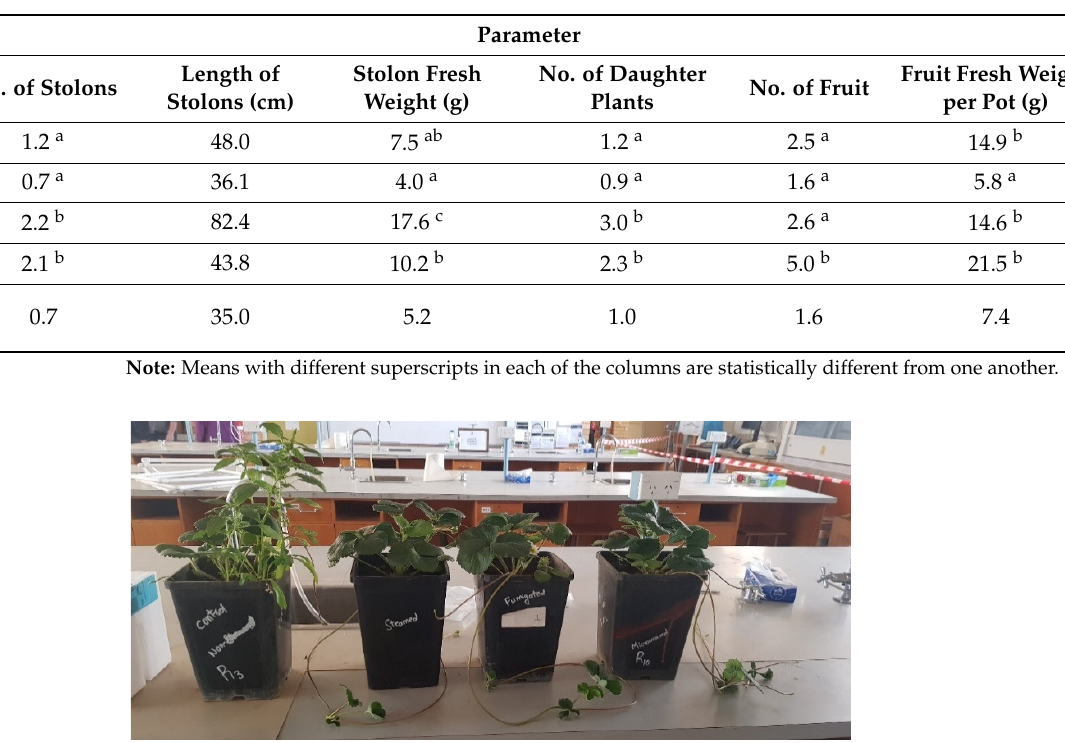
Table 5. Strawberry reproductive and production performance per plant according to individual treatments in a pot experiment (Experiment 3).